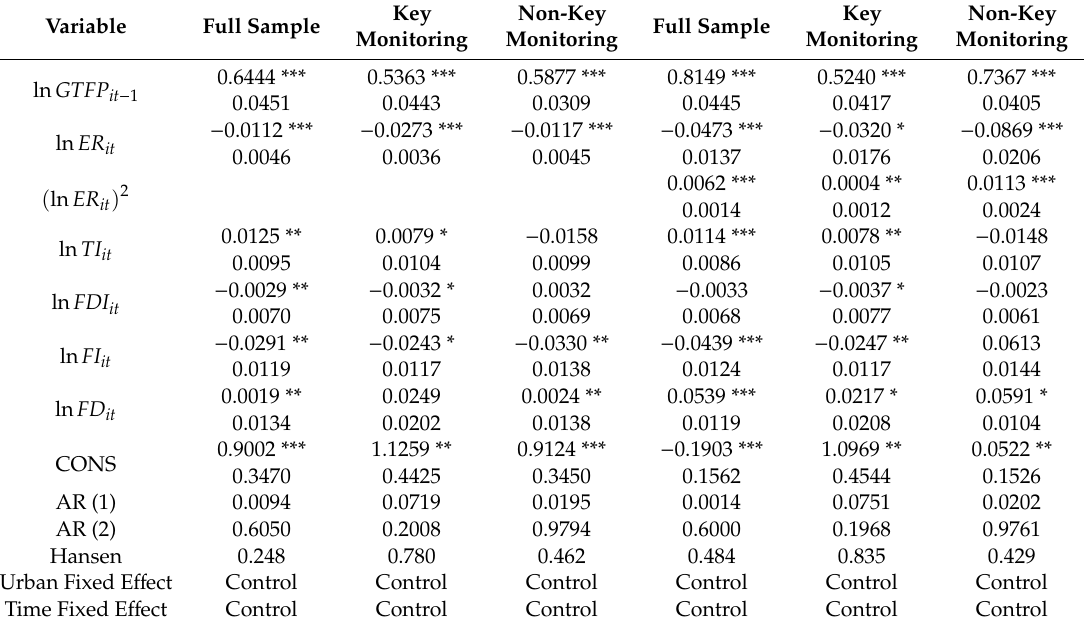
Table A3. Di ff erence GMM regression results of the key monitoring cities and non-key monitoring